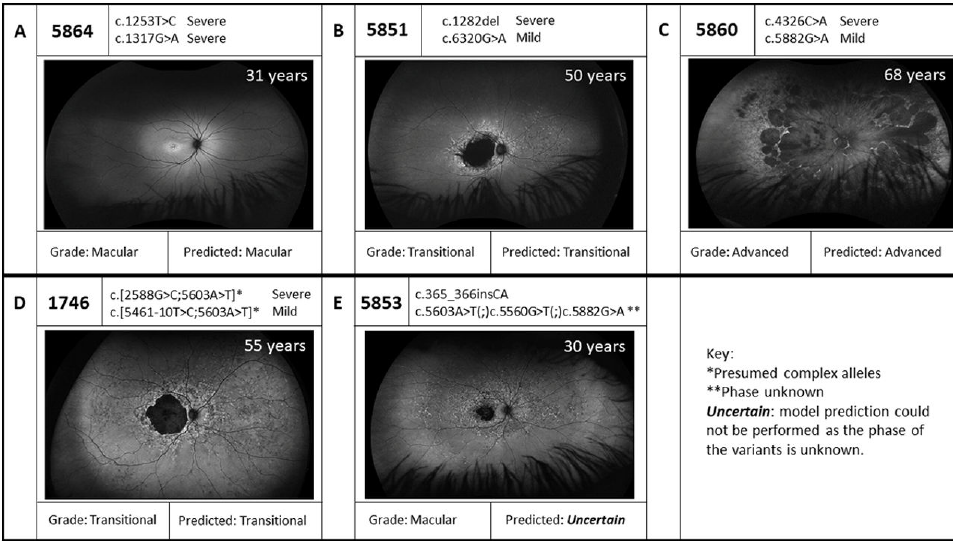
Figure 1. Exemplar genotype–phenotype correlations for ABCA4 -associated disease with associated Ultra Wide Field Autofluorscence images. ( A – C ) show three exemplar cases which fit with the model proposed by Cremers et al. [35] based on grading by an ophthalmologist based on definitions from Cremers and colleagues. ( D , E ) show two cases which show the importance of accurate phasing information for predicting the result of the mutations. Case 1746 has two known complex alleles, allowing the phase to be predicted with a relatively high degree of certainty. Case 5853 has four variants which could not be phased, preventing accurate